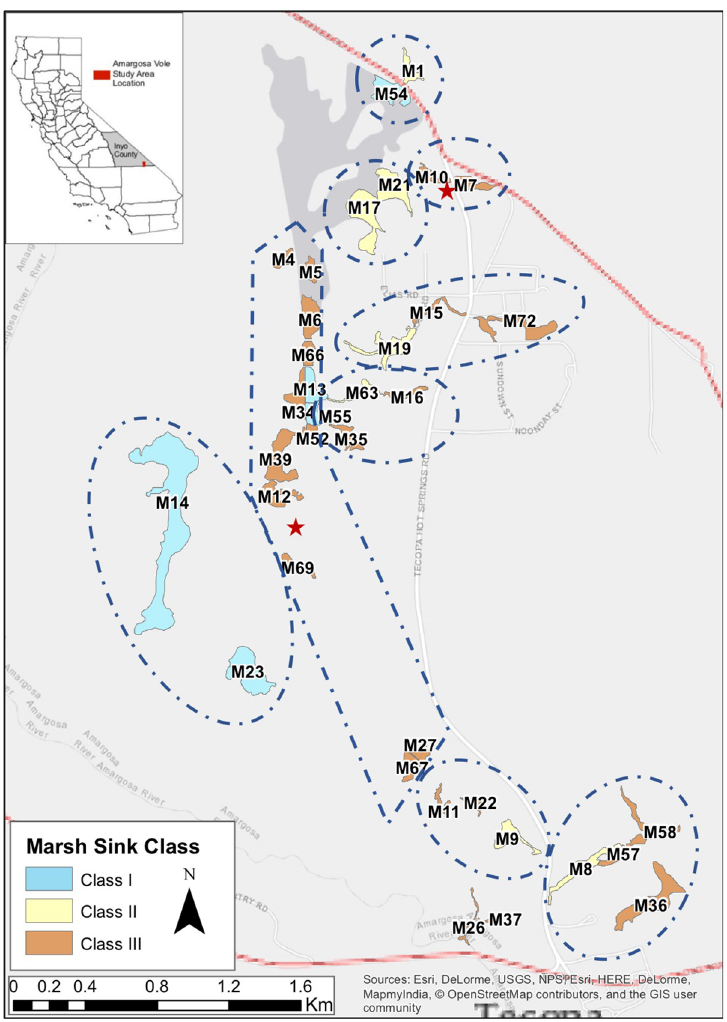
Fig 1. Range map of the Amargosa vole. Map of range and marsh habitat patches of the Amargosa vole, Microtus californicus scirpensis . Marshes are numbered according to conventions of the ad hoc Amargosa vole team. Groups of marshes are outlined based on shared dependency on original water sources. Red stars indicate placement of IS1001 TM -12V Biomark RFID transceiver and integrated corded antennae. Sink class I has a predicted time to extinction (T e ) > 25 yr; class II T e = 10–25 yr, and class III T e < 10 yr.